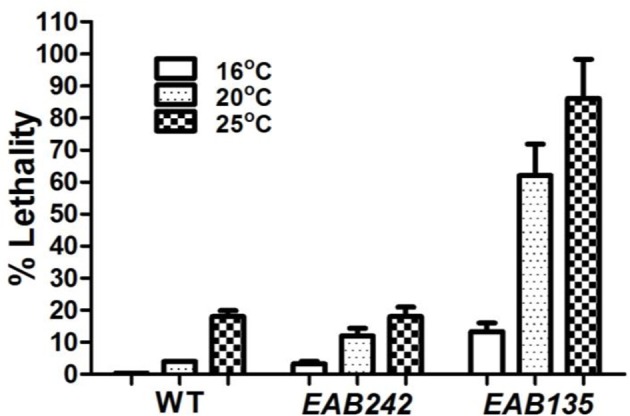
The (G4C2)29 transgene is toxic. Percent lethality on day 10 of adulthood at three different temperatures are shown. The wild-type N2 (WT) strain displayed little or no lethality at any temperature tested. Strain EAB135, carrying the (G4C2)29 transgene, displayed much greater lethality at 20°C or 25°C than strain EAB242, carrying the (G4C2)9 transgene (both P < 0.01).